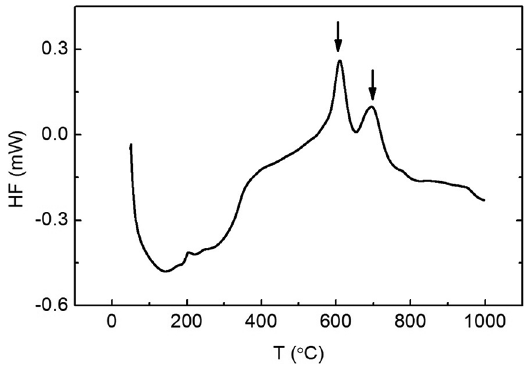
Figure 2. DSC curve for as spun Nd of 50-1000 °C with a heating rate of 20 °C/min under Ar atmosphere.